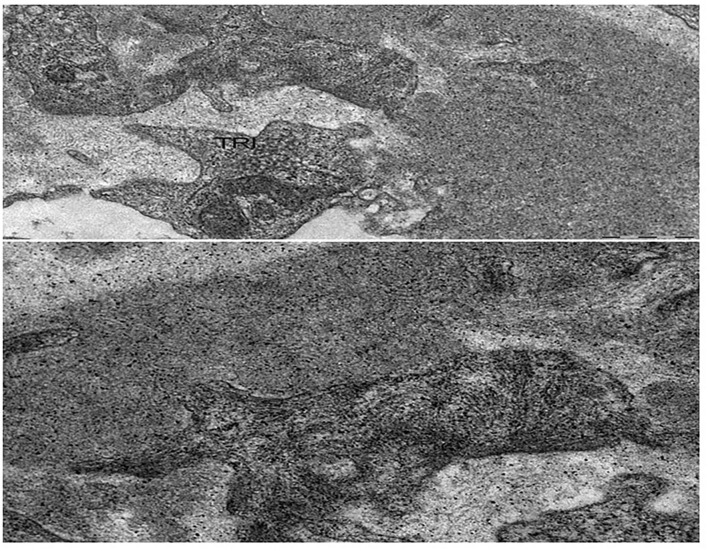
Lupus membranous nephropathy. At electron microscopy, sub-endothelial immune complexes deposits, structured in aggregates of concentric lamellae to form “finger prints” images; a tubulo-reticular inclusion (TRI) is observed in the endothelial cell. Bars: 500 nm.